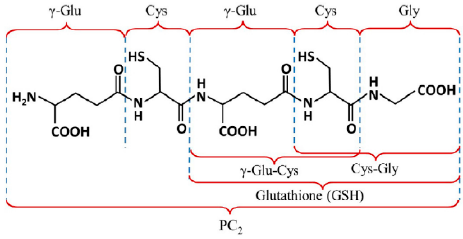
Figure 1. Chemical structure of phytochelatin CRp2 [4].